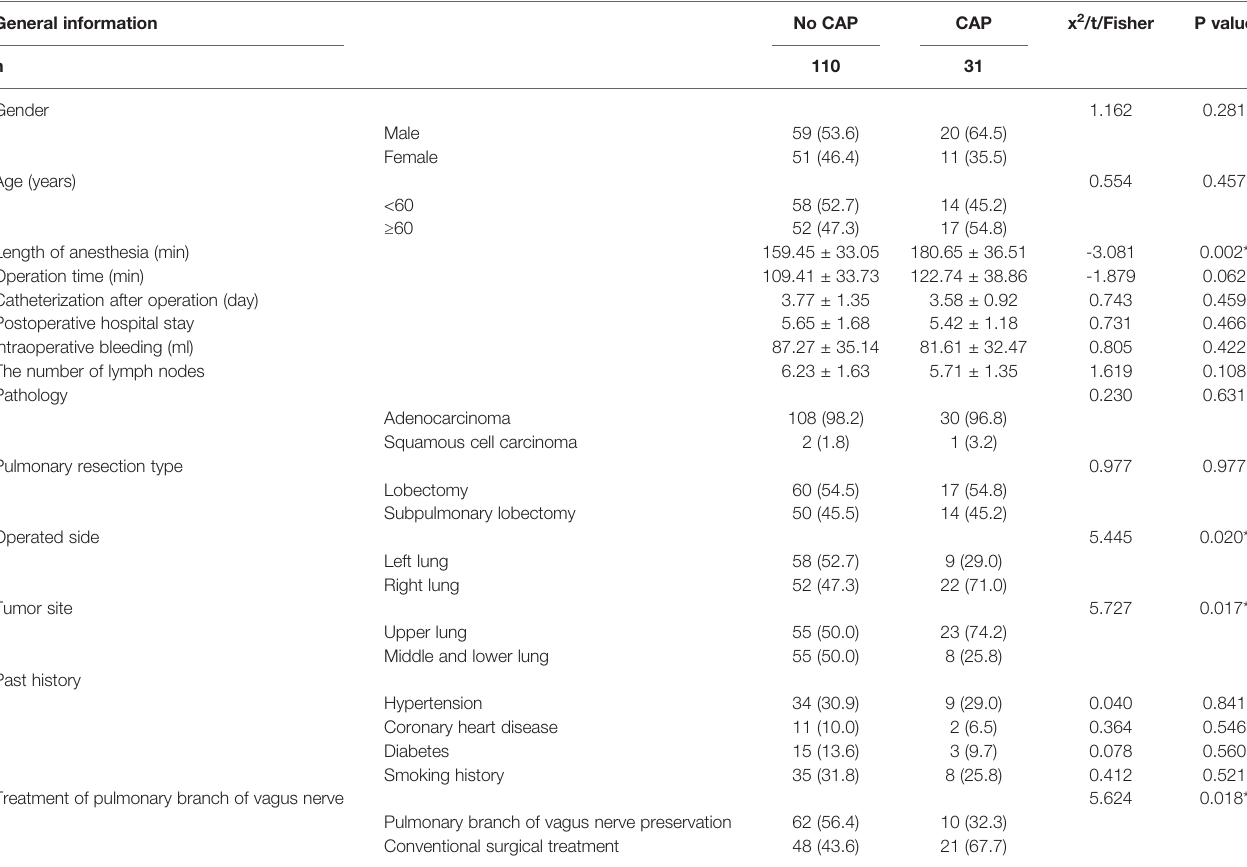
TABLE 5 | Univariate analysis of